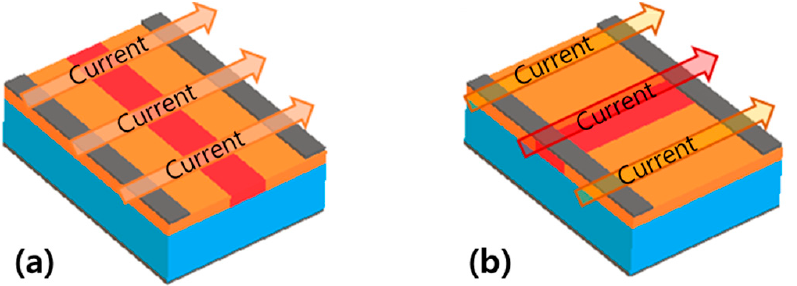
Figure 10. Different mechanisms of current flow depending on the bending direction: ( a ) perpendic- ular bending and ( b ) parallel bending.